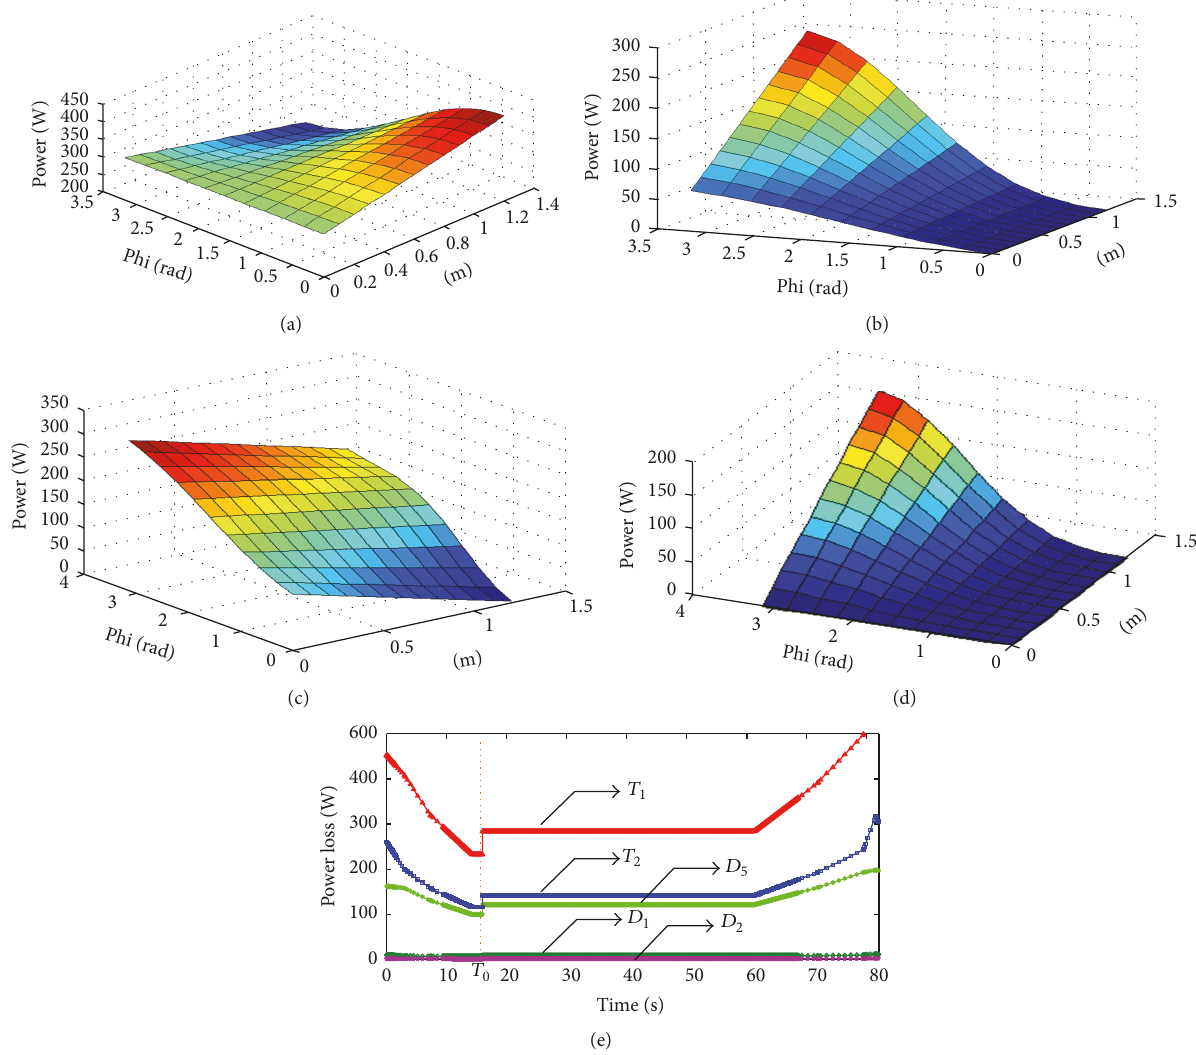
Figure 9: Power loss comparison between two equivalent modes. (a) Power loss of 𝑇 1 based on simplified SVPWM; (b) power loss of 𝑇 1 based on quasi-square-wave modulation; (c) power loss of diode based on simplified SVPWM; (d) power loss of diode based on quasi-square-wave modulation; (e) power loss curves of power devices under dual-mode